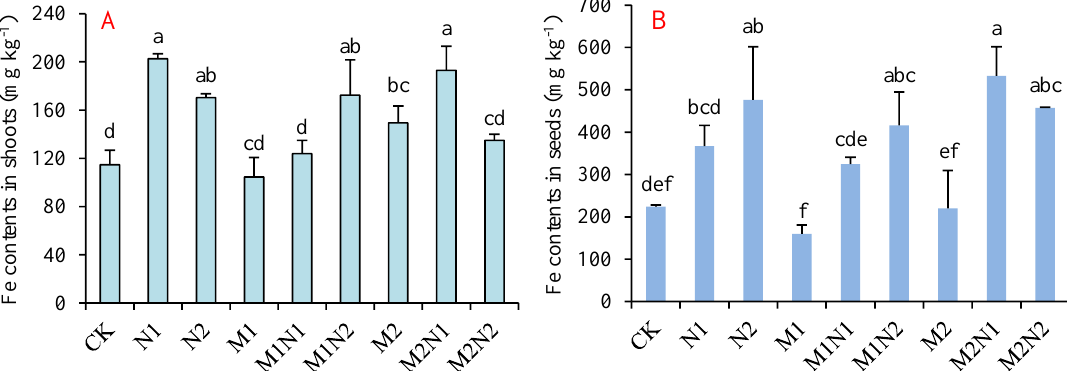
Figure 5. Iron contents in soybean shoots ( A ) and seeds ( B ). CK: no fertilizer, N1: low nitrogen, N2: high nitrogen, M1: low manure, M1N1: low manure and low nitrogen, M1N2: low manure and high nitrogen, M2: high manure, M2N1: high manure and low nitrogen, M2N2: high manure and high nitrogen. Different lower – case letters denote significant differences between treatments by least – significant difference at the 5% level.